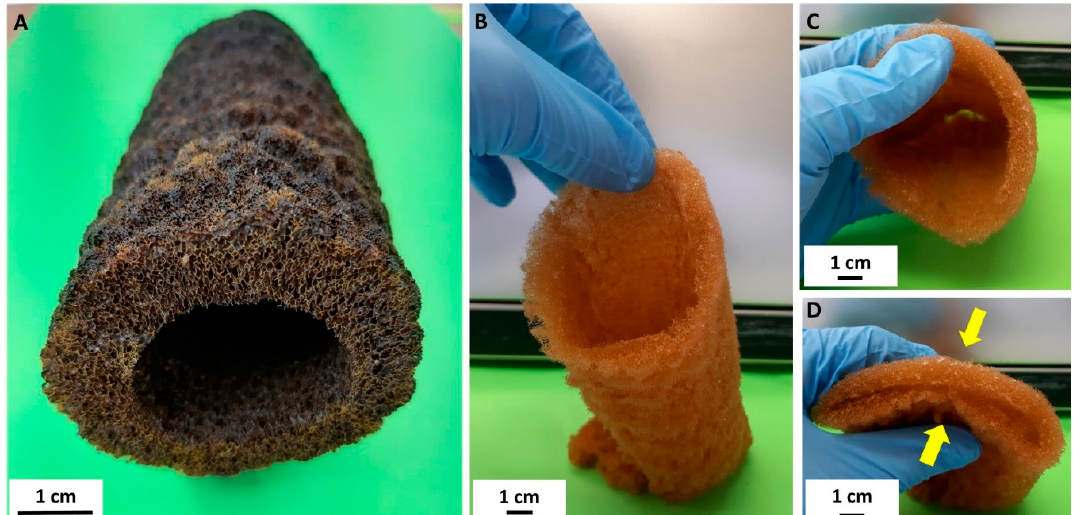
Figure 1. A selected air-dried fragment of Aplysina archeri sponge skeleton is rigid and represents the typical tube-like morphology of verongiids ( A ). Decellularization with subsequent demineralization of this construct [6,26] leads to isolation of the flexible chitinous scaffold ( B – D ), which reproduces the shape, form, and structural features of the original tubular sponge skeleton, with a length of up to 1.5 m.